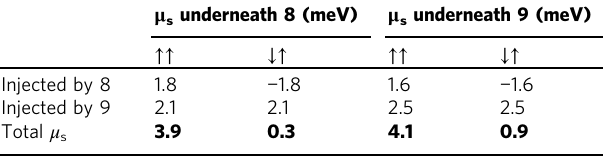
Spin accumulation μ s in graphene, beneath the contacts, in the two-terminal spin-valve geometryatbias I = +20 μ A.Thearrows ↑↑ ( ↓↑ )representtheparallel(anti-parallel)orientation of the magnetization of contacts 8 and 9, respectively, from left to right. Bold values represent the total spin accumulation in different magnetization orientation of